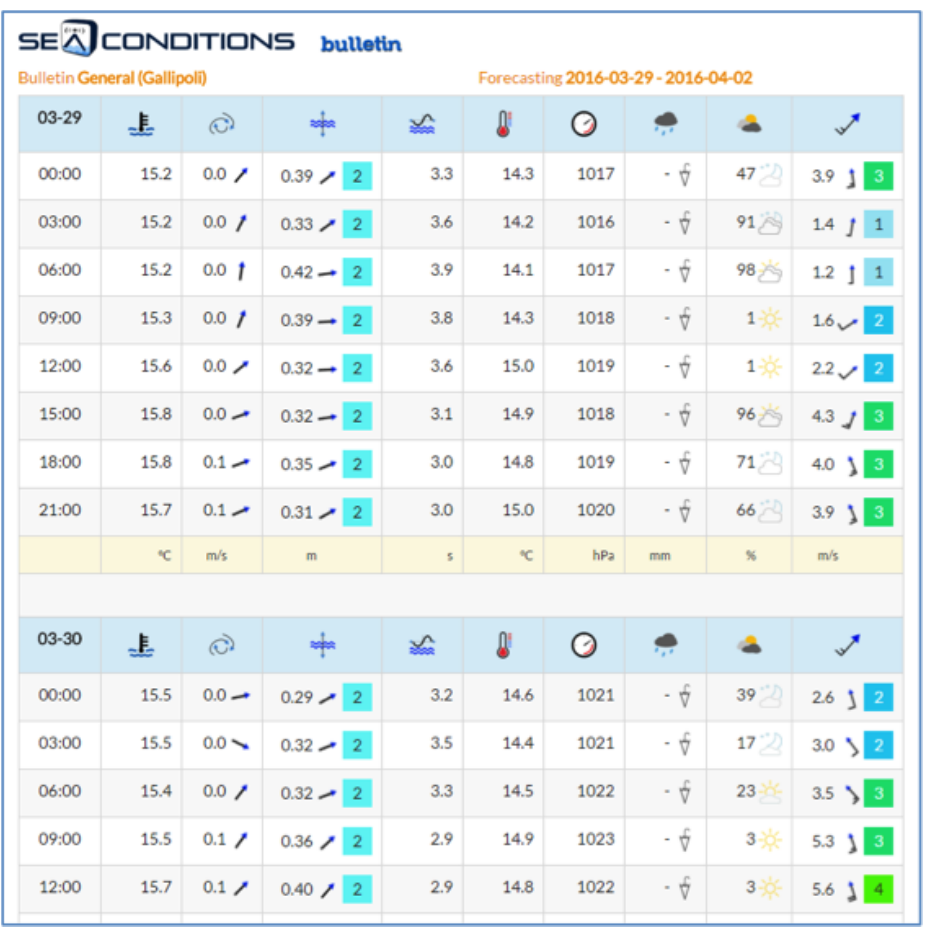
Figure 10. MySeaConditions – example of the daily forecast bulletin generated for the location of Gallipoli in Fig.